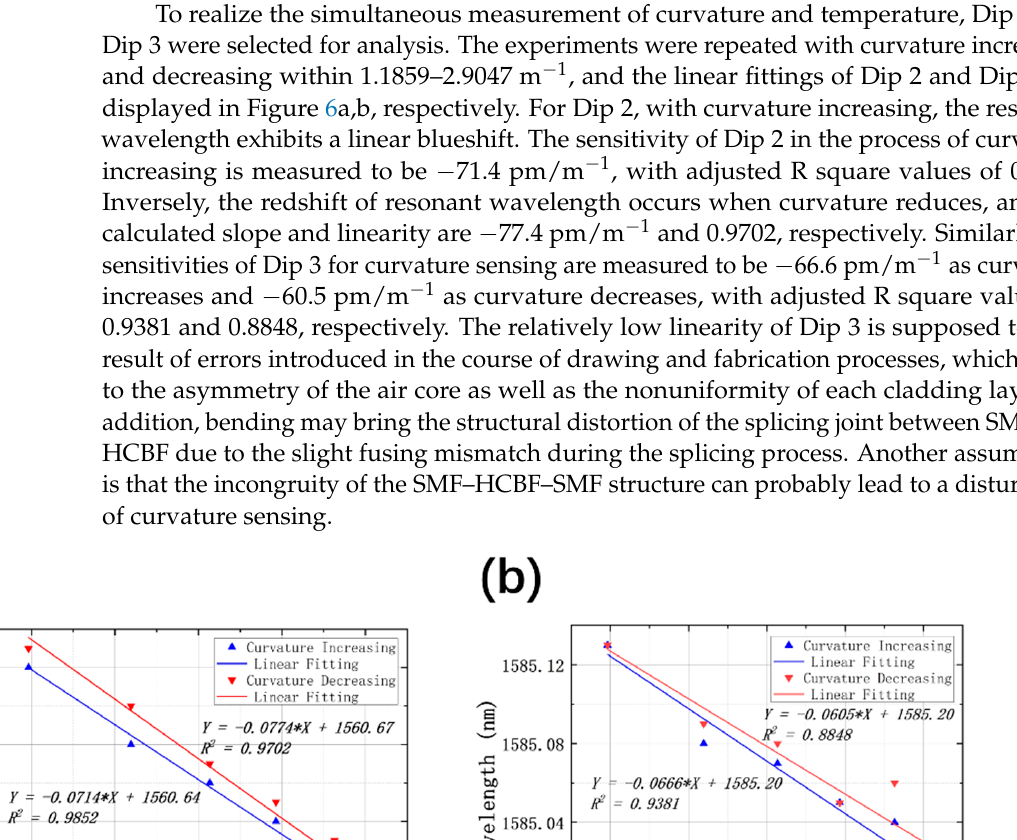
Figure 5. ( a ) Transmission spectra of the HCBF-based sensor under different curvature values; ( b ) enlarged transmission spectra in the region of Dip 2, inset shows the relationship between intensity of Dip 2 and curvature.